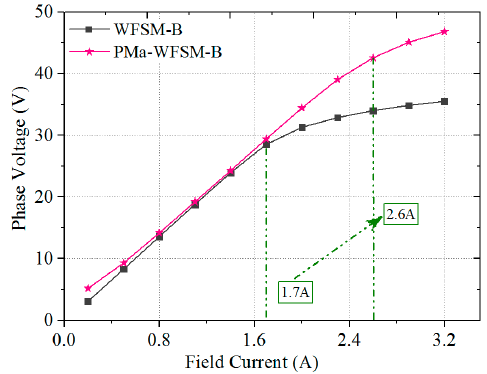
Figure 8. Calculated saturation curves.